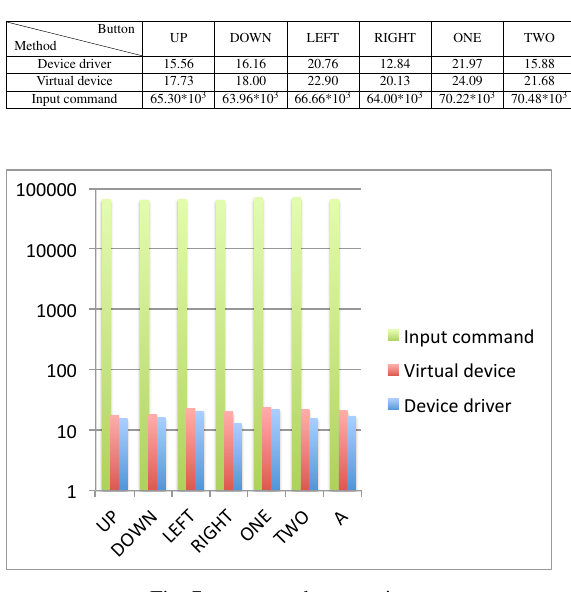
Fig. 7. compare three versions